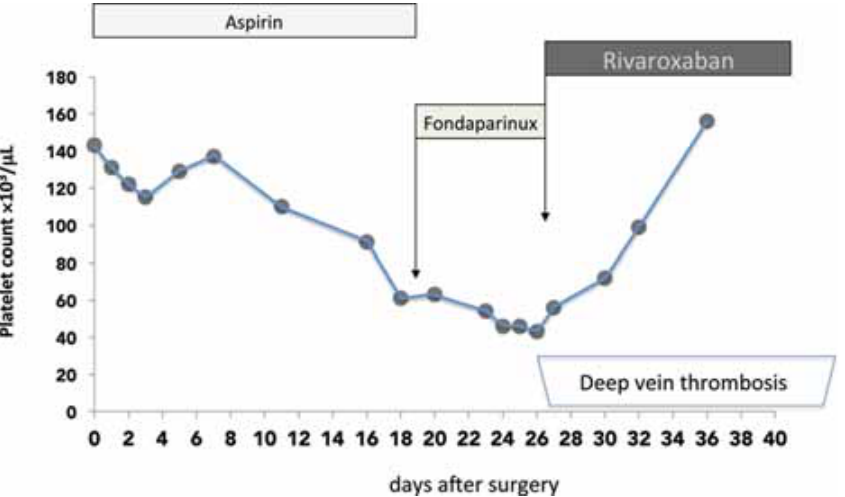
Fig. 1 Trend in platelet counts after carotid endarterectomy (D0: day 0). On D0 a bolus of heparin dose of 5,000 U was used, 27 days afterwards (D27) a thrombosis con fi ned to the internal gastrocnemius vein and to the soleal vein occurred (deep vein thrombosis). Fondaparinux: fondaparinux 5 mg once a day, Rivaroxaban: rivaroxaban 15 mg twice a